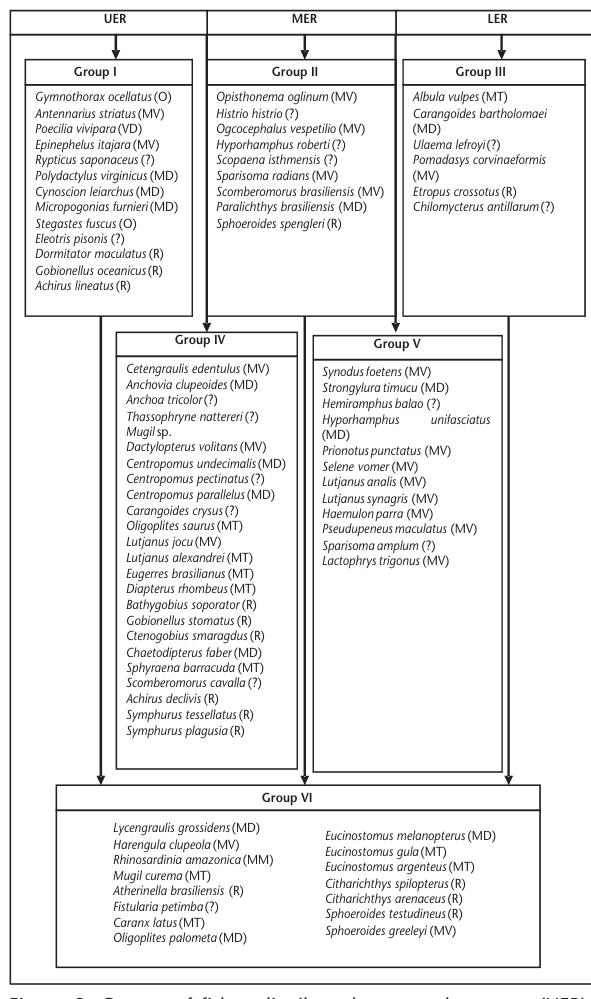
Figure 2. Groups of fishes distributed among the upper (UER), mid (MER), and lower (LER) estuarine regions of the Rio Formoso, and their corresponding classification: resident (R), marine-depen- dent (MD), migrants in trophic ecophase (MT), marine visitors (MV), marine migrants (MM), occasional (O), and freshwater visi- tors (FV). (?) Unavailable